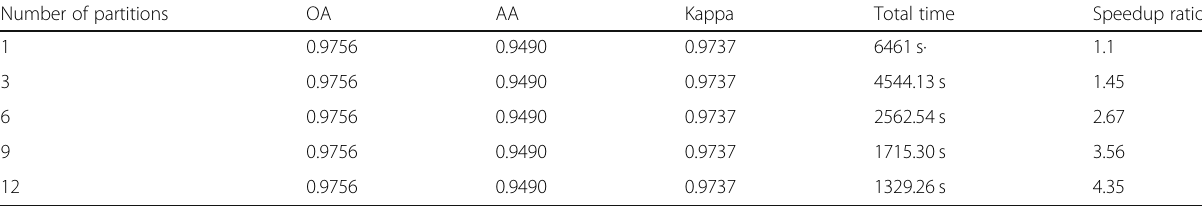
Table 2 Data set processing results with different numbers of partitions Number of